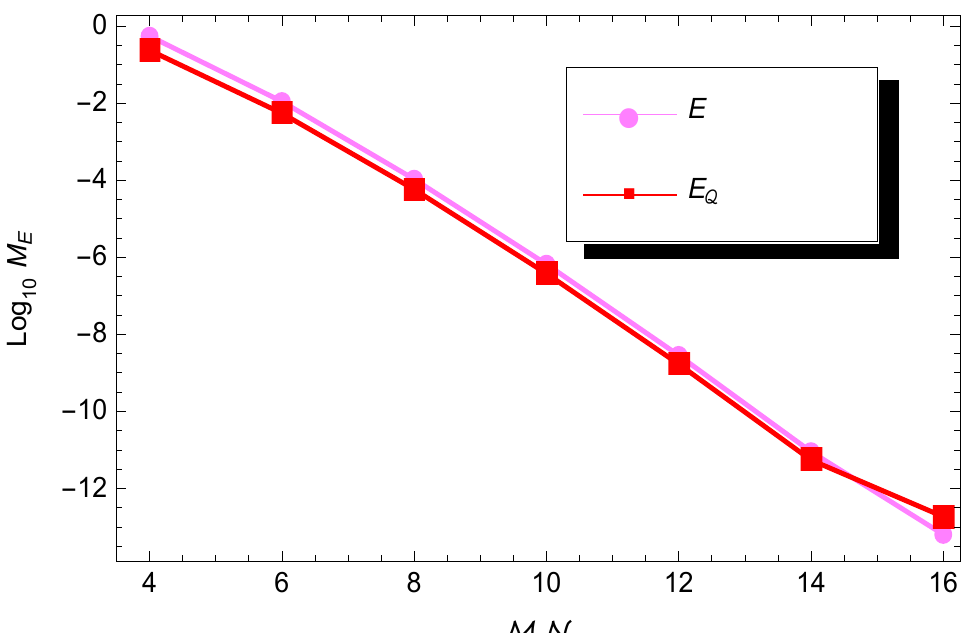
Figure 8. M E convergence of problem (30), where σ 1 = (cid:36) 1 = σ 2 = (cid:36) 2 = 0, ν =